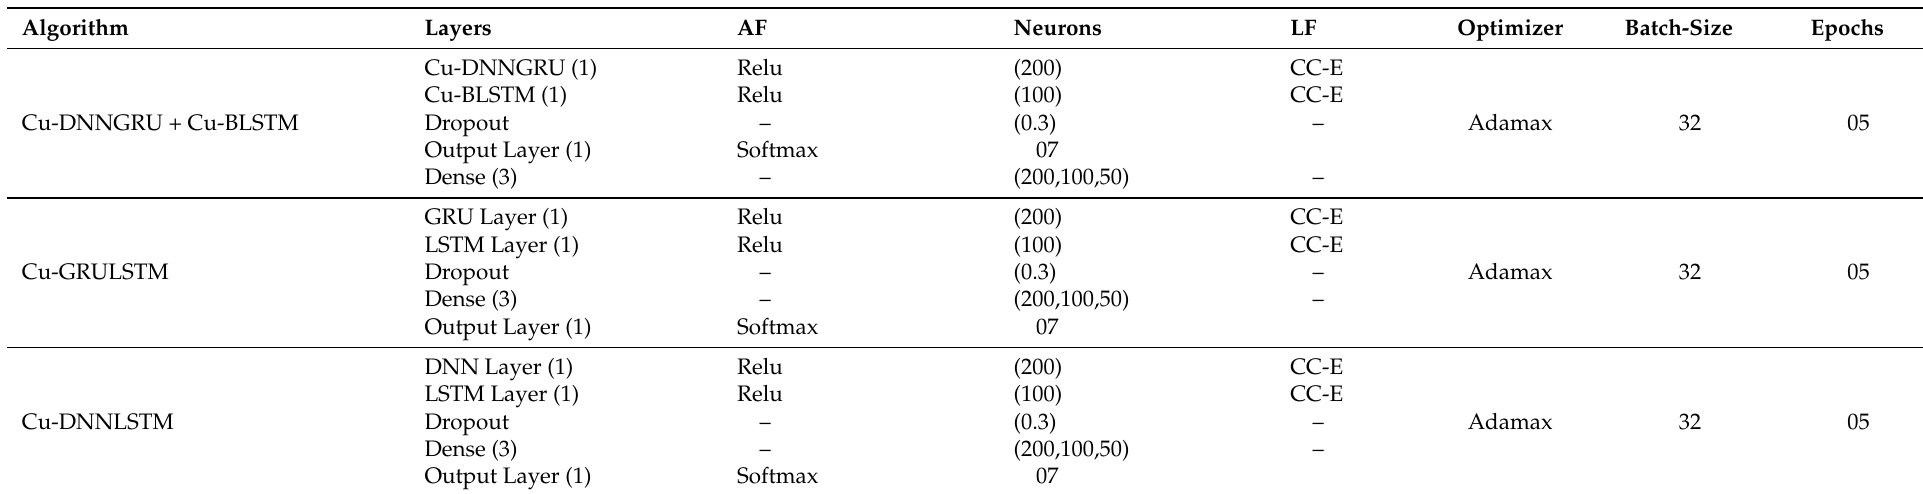
Table 2. Hybrid algorithms